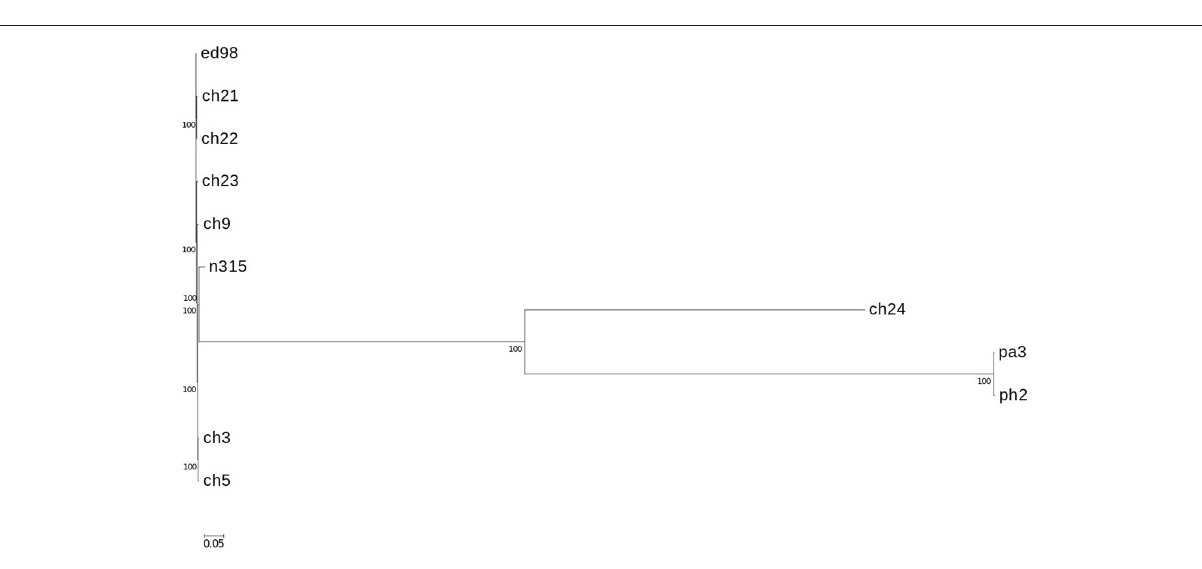
first striking difference between the strains was the total length of their genomes, which was 2.8 and 3.1 Mbp, respectively, for the virulent and non-virulent strains. The additional genetic pool of over 250 kbp within the genome of ch22 arose mainly from three duplications. The longest one (CP017807 1552041.